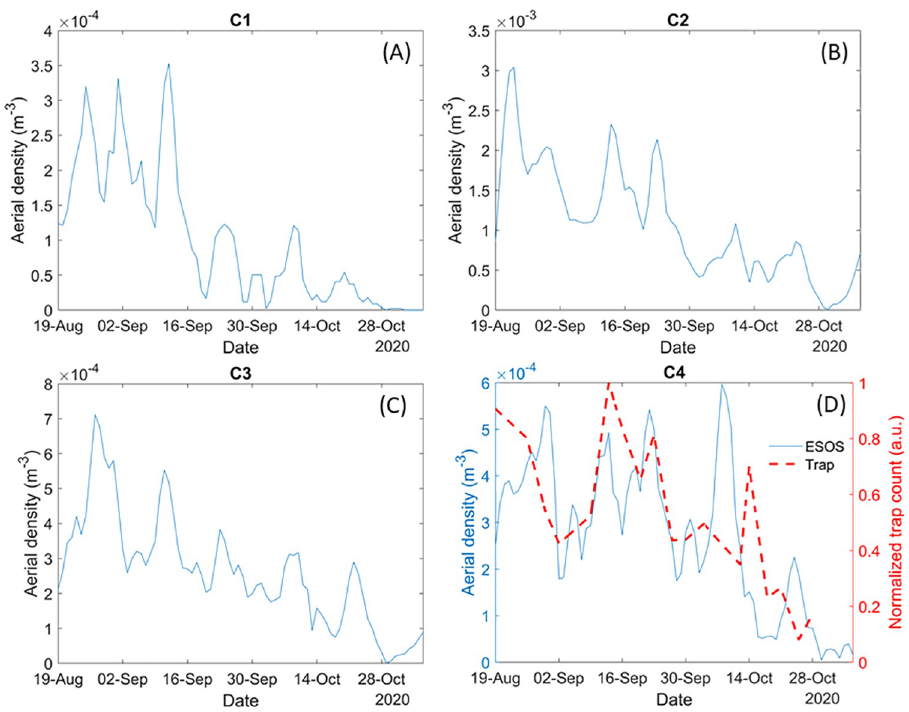
Fig 8. Evolution of the aerial density for clusters C1, C2, C3 and C4 (respectively A, B, C and D) over the 80 days of the measurement campaign. Figure D also displays the normalized trap count (red dashed) of nearby traps for comparison